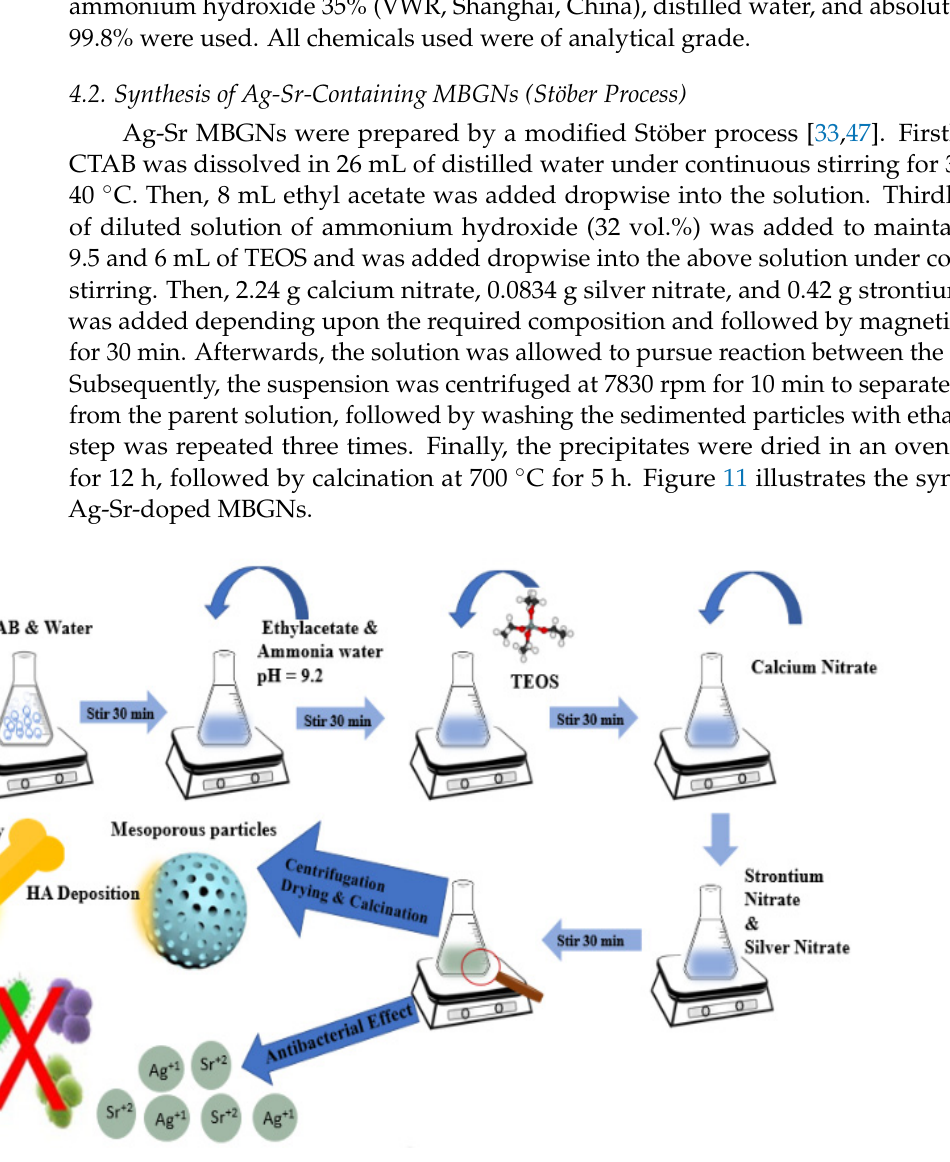
Figure 11. Synthesis of Ag-Sr-doped mesoporous bioactive glass nanoparticles (Ag-Sr MBGNs) modified by the Stöber method.